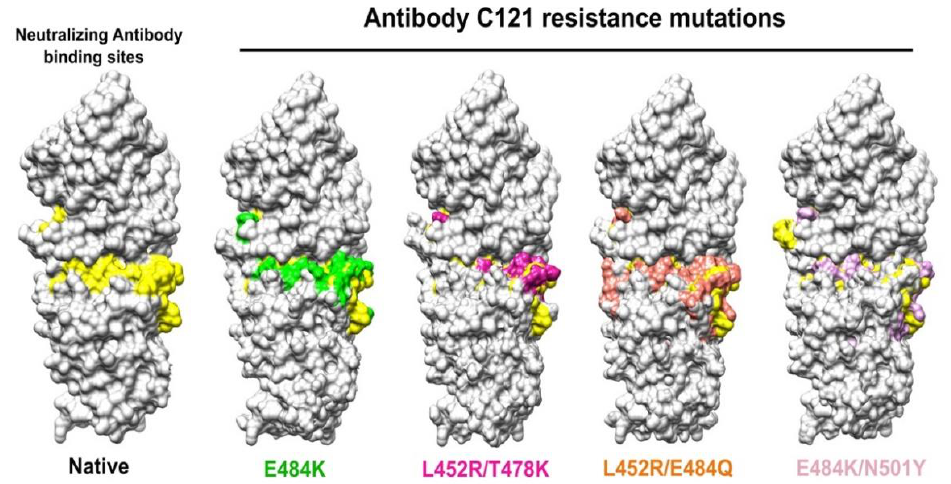
Figure 4. The change in antibody binding sites in the double mutants L452R/T478K (Delta), L452R/E484Q (kappa) and E484K/N501Y (Beta) compared with native antibody binding sites.